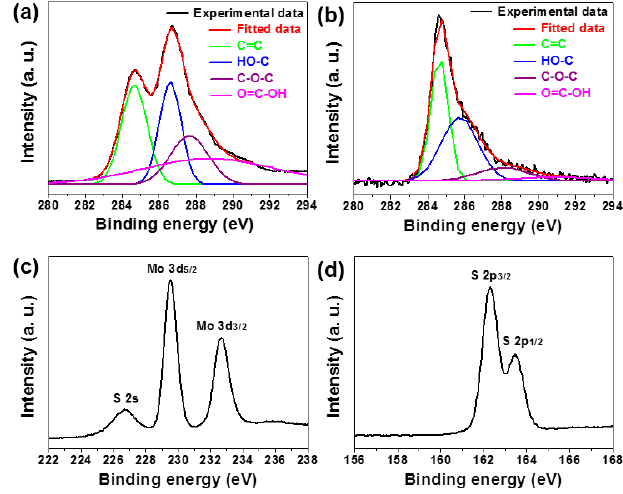
Figure 5. ( a ) High-resolution XPS spectrum of tiny GO sheets, showing the C 1s region; ( b – d ) High-resolution XPS spectra of MoS 2 /RGO hollow microspheres, exhibiting C 1s, Mo 3d, and S 2p regions,